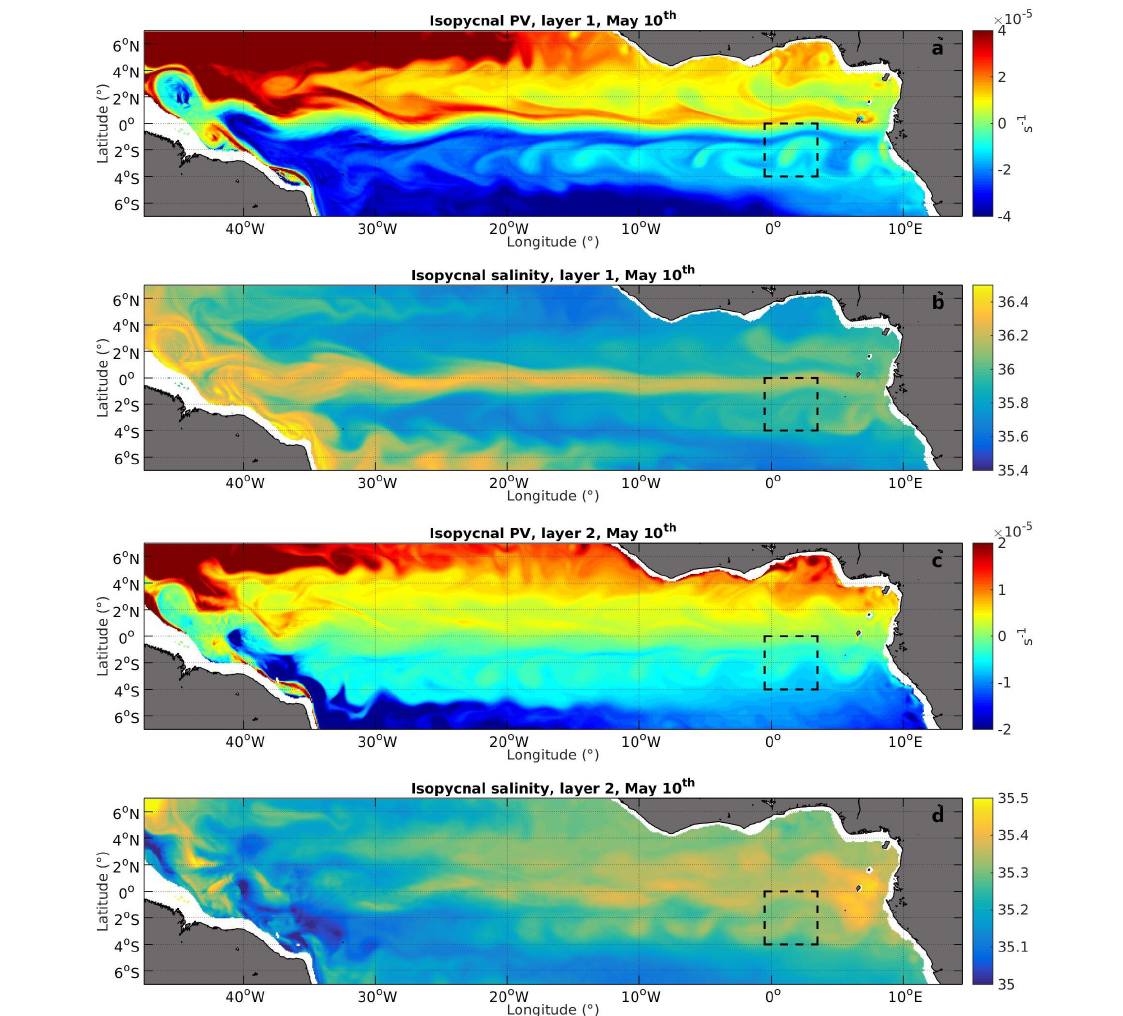
Figure 7. Horizontal map of the PV fields in layers 1 and 2 ( a , c ) on 10 May, and horizontal map of the salinity fields averaged between isopycnic levels defining layers 1 and 2 (panels ( b , d )) on 10 May. The dashed box indicates the eddy that is